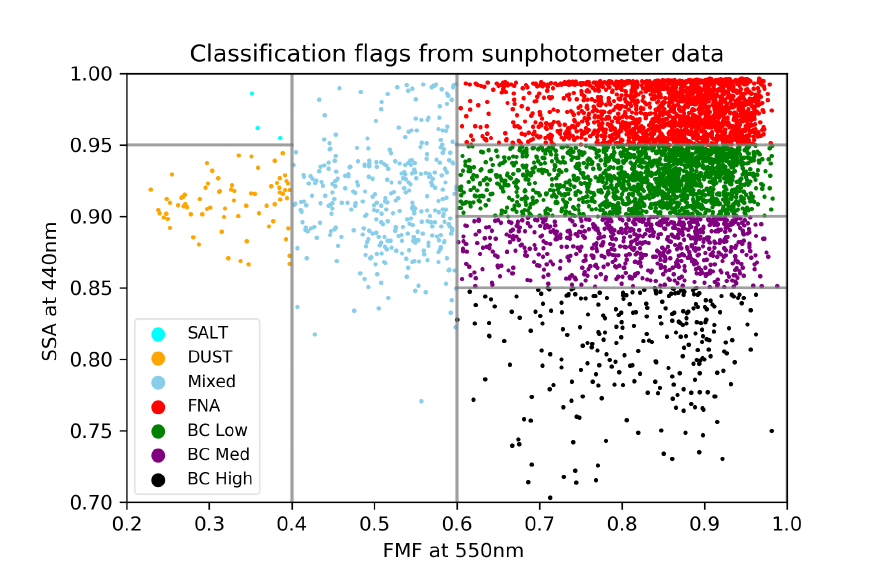
Figure 2. The classification flags obtained by applying the scheme of [6] on sunphotometer data (5270 cases). Thresholds are applied on the FMF550 and SSA440 in order to assign each case in one of the clusters. The following clusters are defined: SALT (upper left), DUST (lower left), Mixed (middle), FNA (upper right), BC Low (2nd right), BC Med (3rd right), and BC High (lower